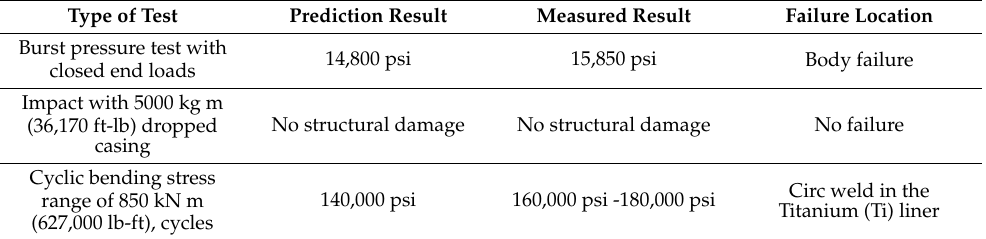
Table 9. Results of composite riser joints with 22” ID by ConocoPhillips/AkerKvaerner (Source: [65]).